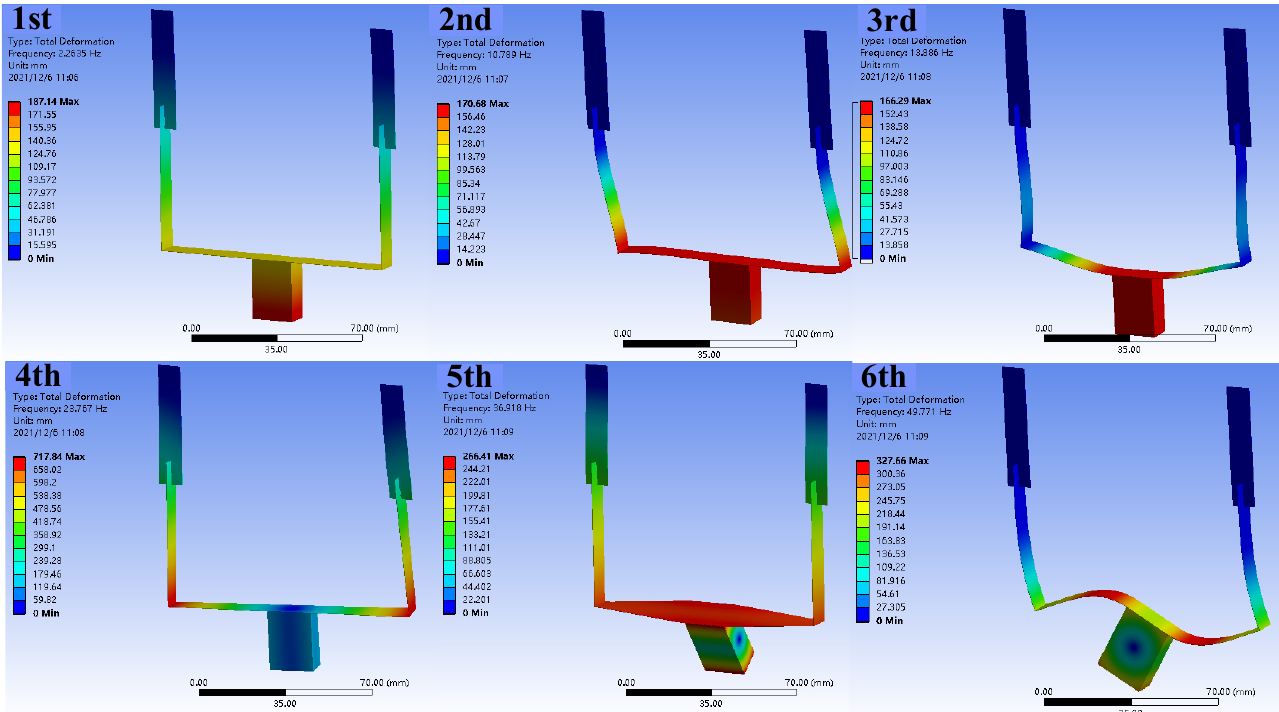
Figure 2. The stress distribution in the proposed U-shaped structure when stimulated by ( a ) x-axis, ( b ) y-axis, and ( c ) z-axis accelerations.